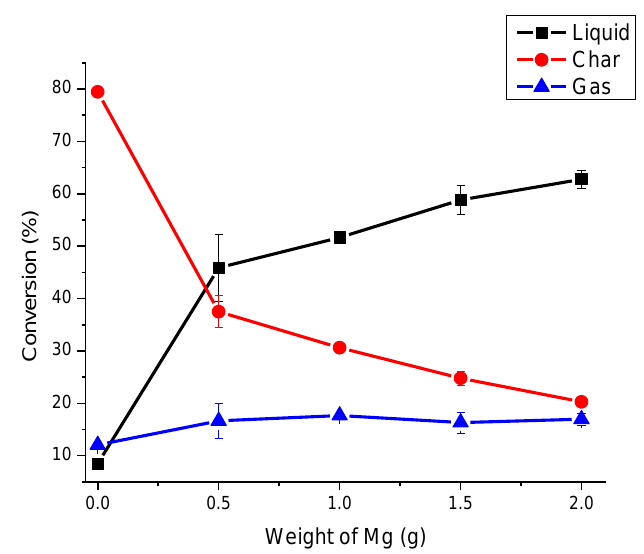
Figure 2. Weight of Catalyst Optimization for Catalytic Cracking of Tube